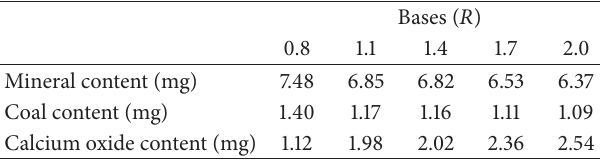
Table 4: Compositions of each type of materials